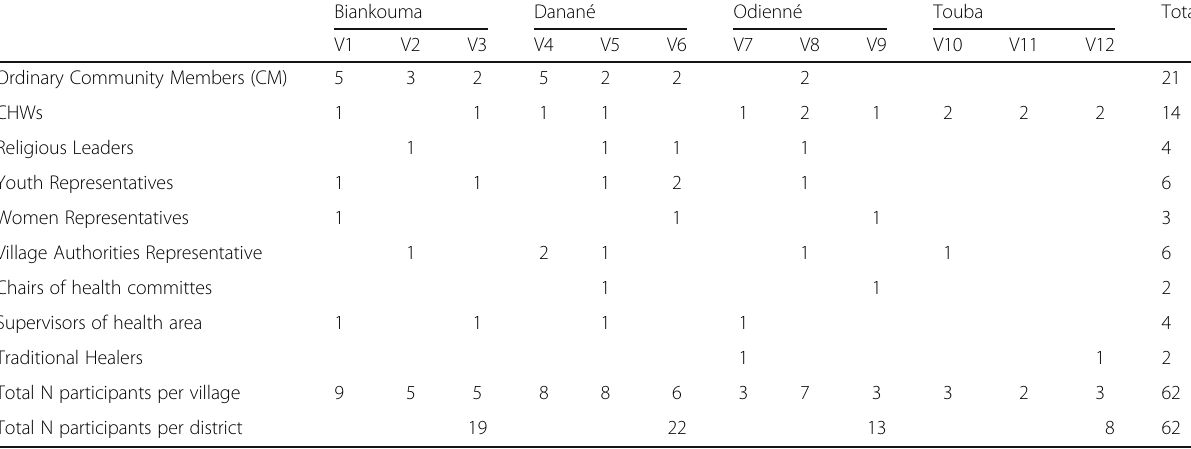
Table 2 Respondents ’ profile in each of the 12 villages (V1 to